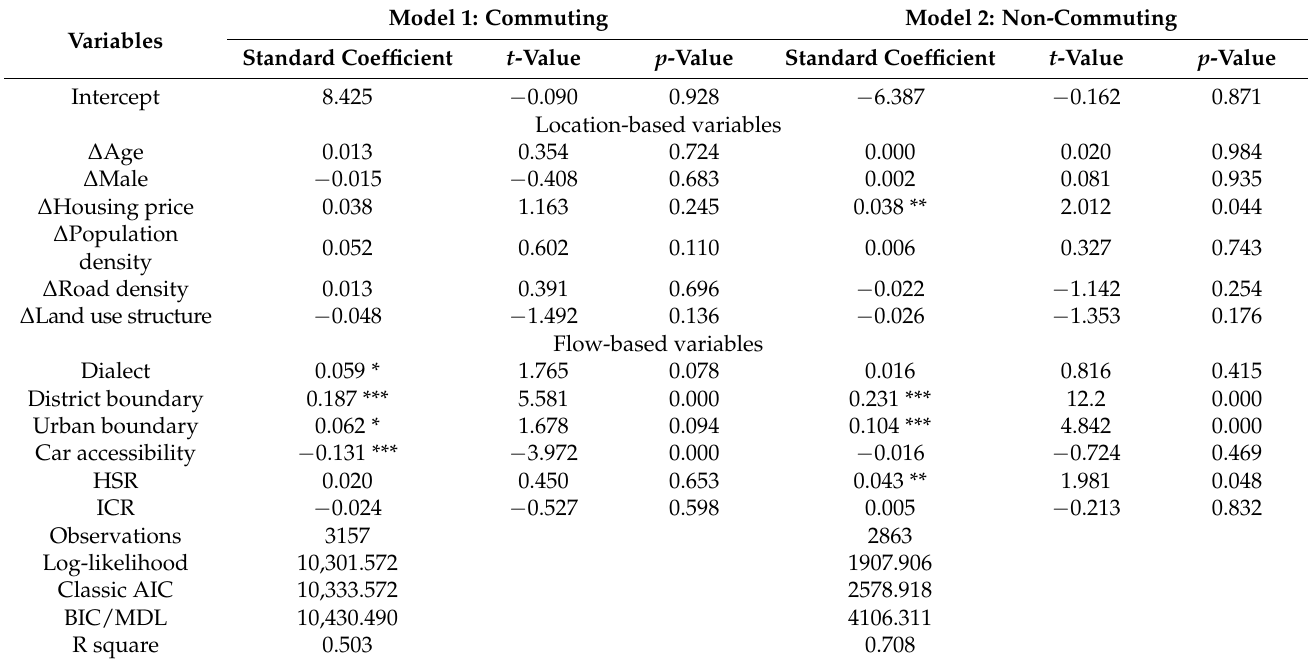
Table 2. Results of ordinary regression